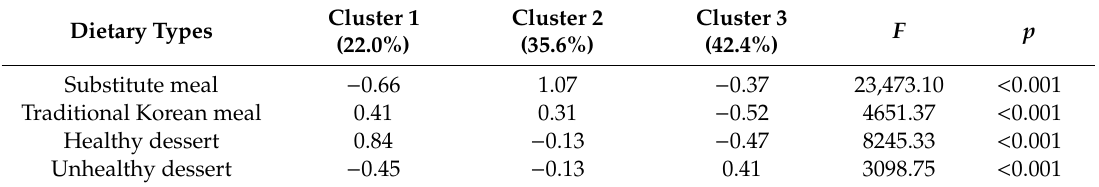
Table 3. Results of cluster analysis using four factor scores ( n = 6719).